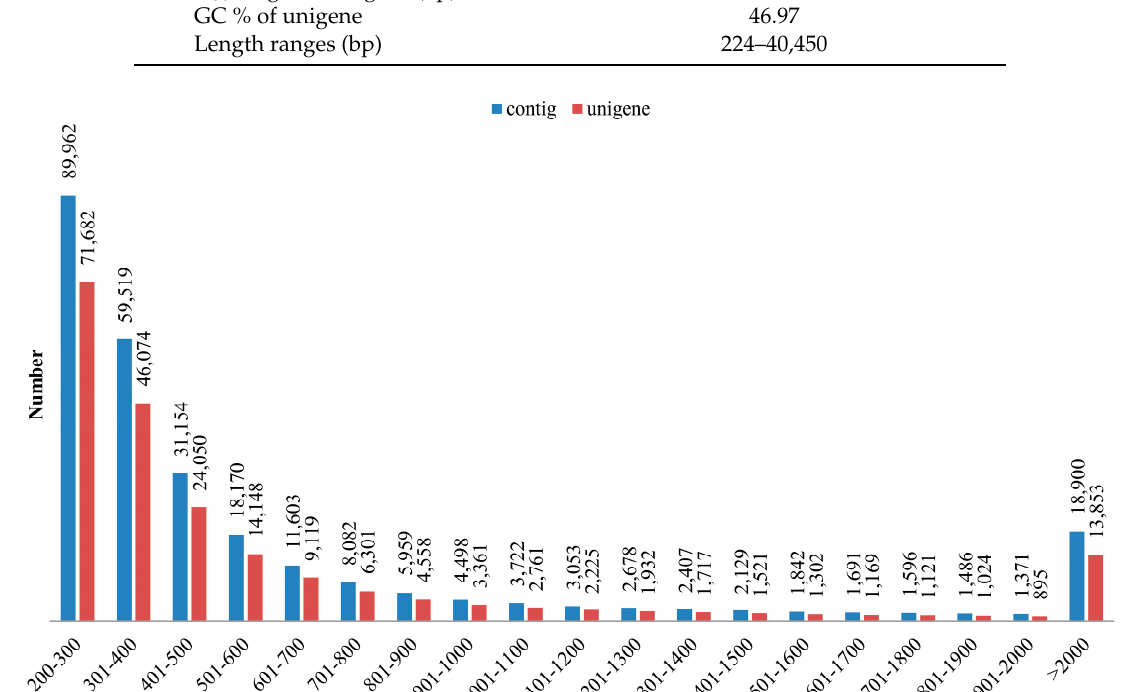
Figure 1. Size distribution of contigs (blue) and unigenes (red) after assembly and clustering of the quality reads from the transcriptome of T. longicaudatus .